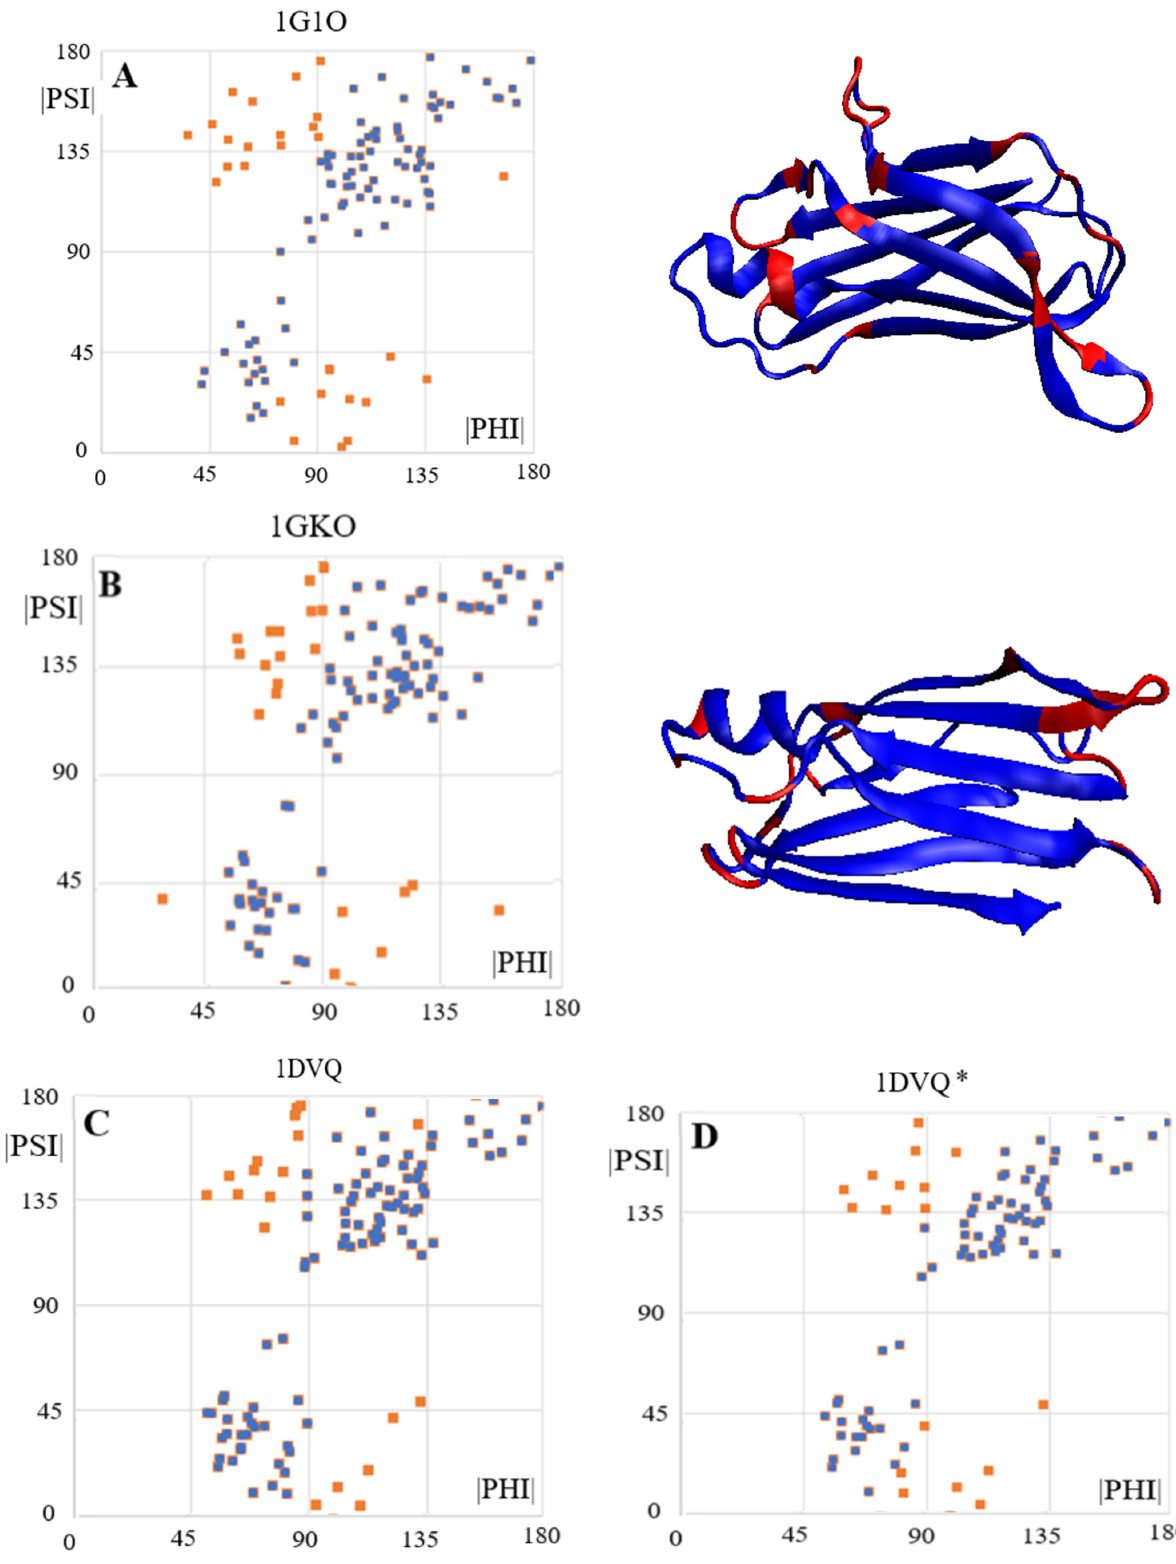
Figure 9. Location of points representing the Phi and Psi angles for: ( A )—1G1O and the distribution of items treated as outstanding (red in the 3D presentation); ( B )—1GKO and the distribution of items treated as outstanding (red in the 3D presentation); ( C )—1DVQ. ( D )—1DVQ. * Colour scheme as in previous figures.